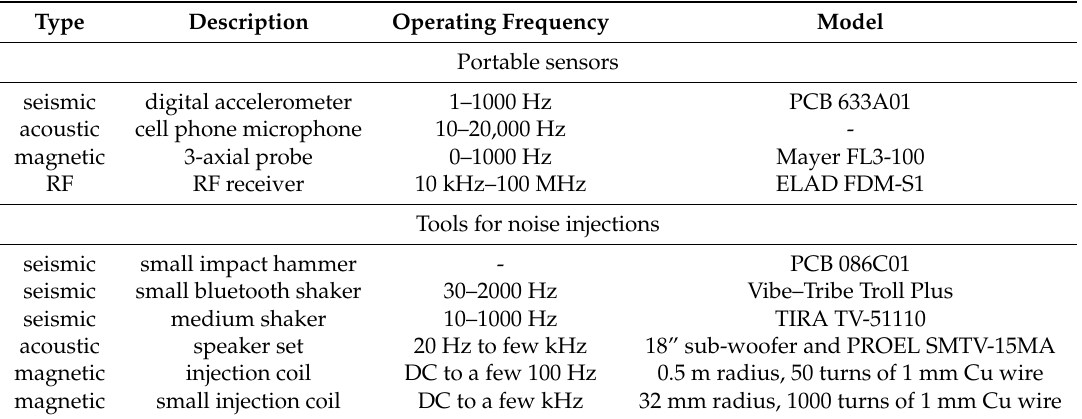
Table 2. The hunter’s tool-kit: set of tools for investigating environmental